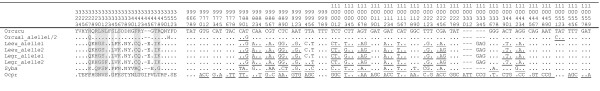
Amino acid and nucleotide sequences of Lagomorpha PRYSPRY v1 region. Amino acid and nucleotide sequences of PRYSPRY v1 region are represented for European rabbit subspecies Oryctolagus cuniculus cuniculus (Orcucu) and Oryctolagus cuniculus algirus (Orcual), European brown hare (Leeu - allele 1 and 2), Iberian hare (Legr - allele 1 and 2), brush rabbit (Syba) and American pika (Ocpr). The shadowed region on the amino acid representation corresponds to positively-selected sites obtained by REL analysis. Non-synonymous substitutions are underlined on the nucleotide sequences of Lagomorpha PRYSPRY v1 region. Residues are numbered as in Figure 1.